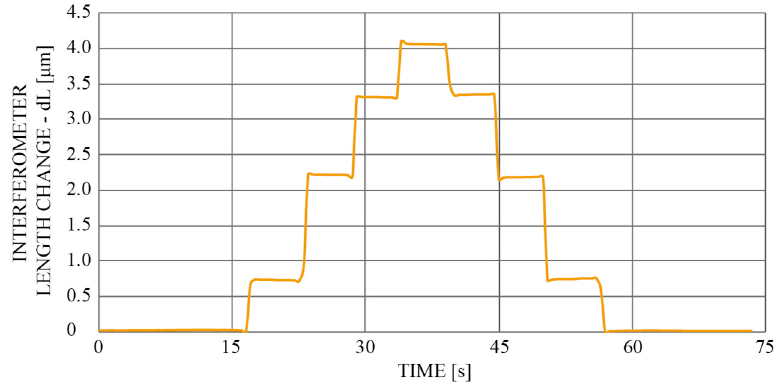
Figure 10. Calculated sensor elongation for 4 µ m.